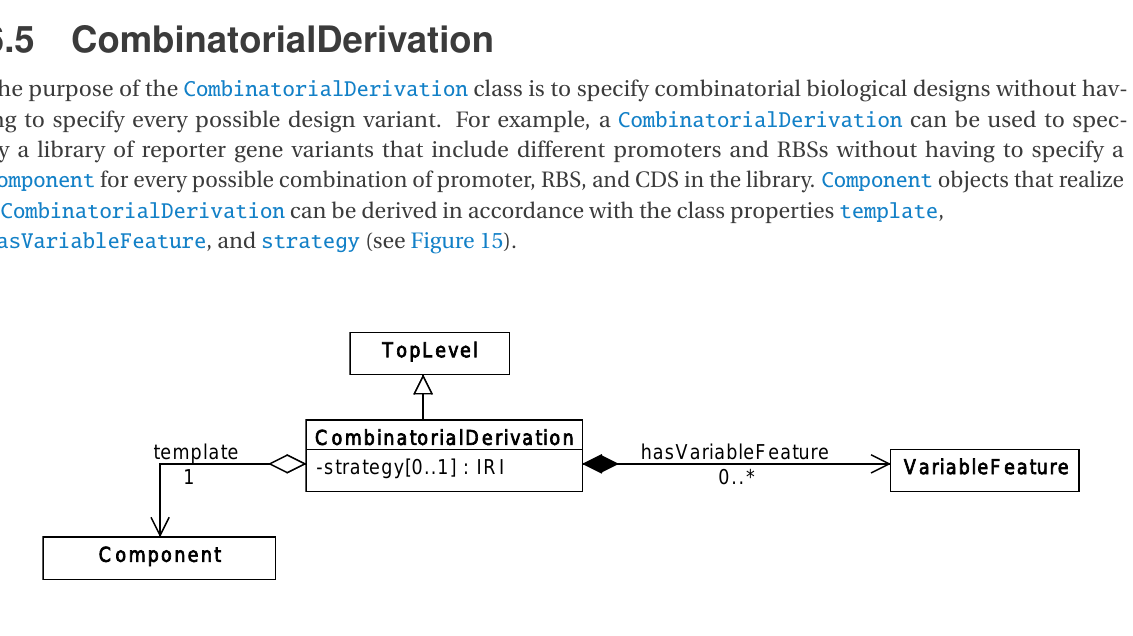
Figure 15: Diagram of the CombinatorialDerivation class and its associated